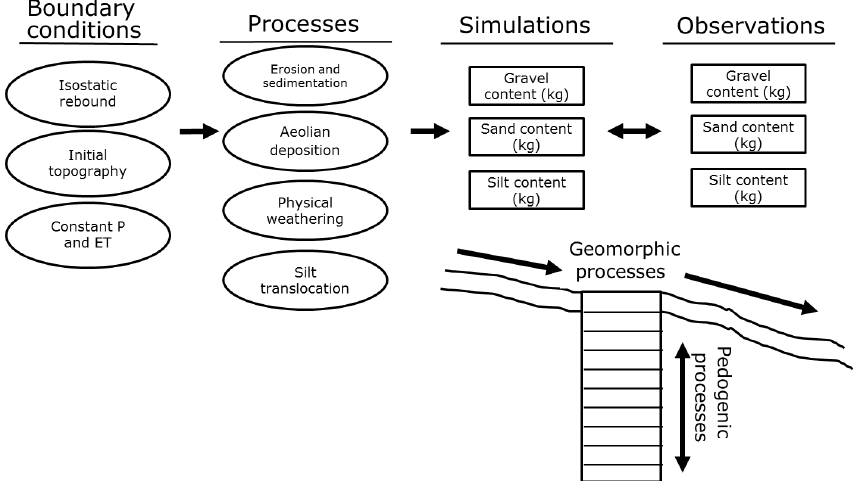
Figure 2. Conceptual framework of LORICA as used in this